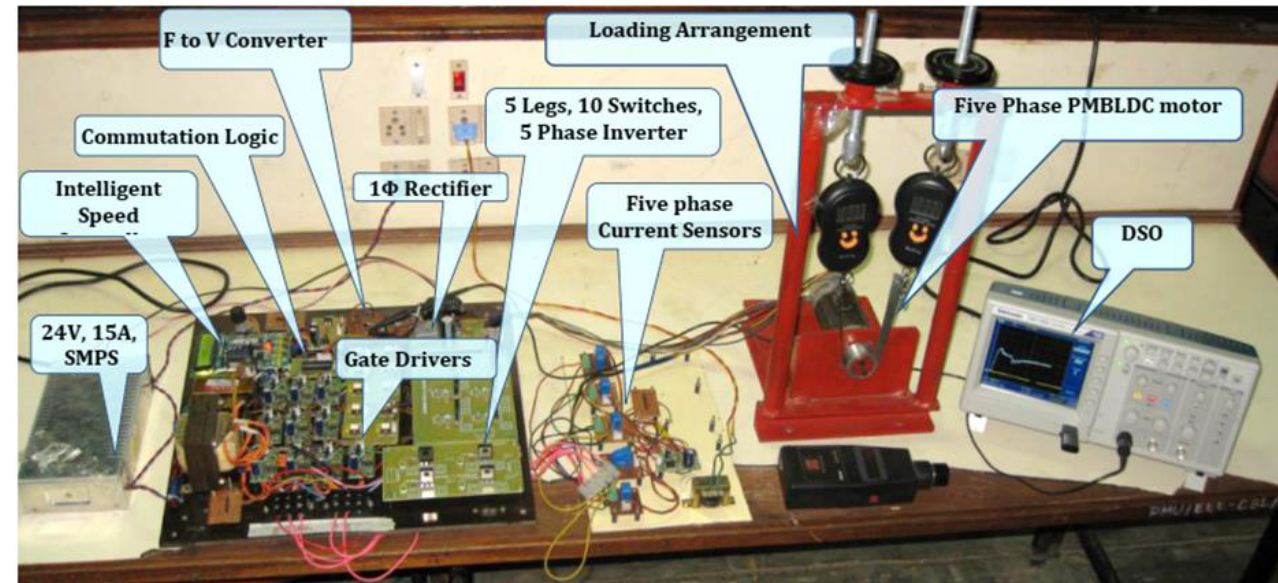
Figure 11. Hardware setup depicting a five-phase intelligent controller-fed PMBLDC drive.